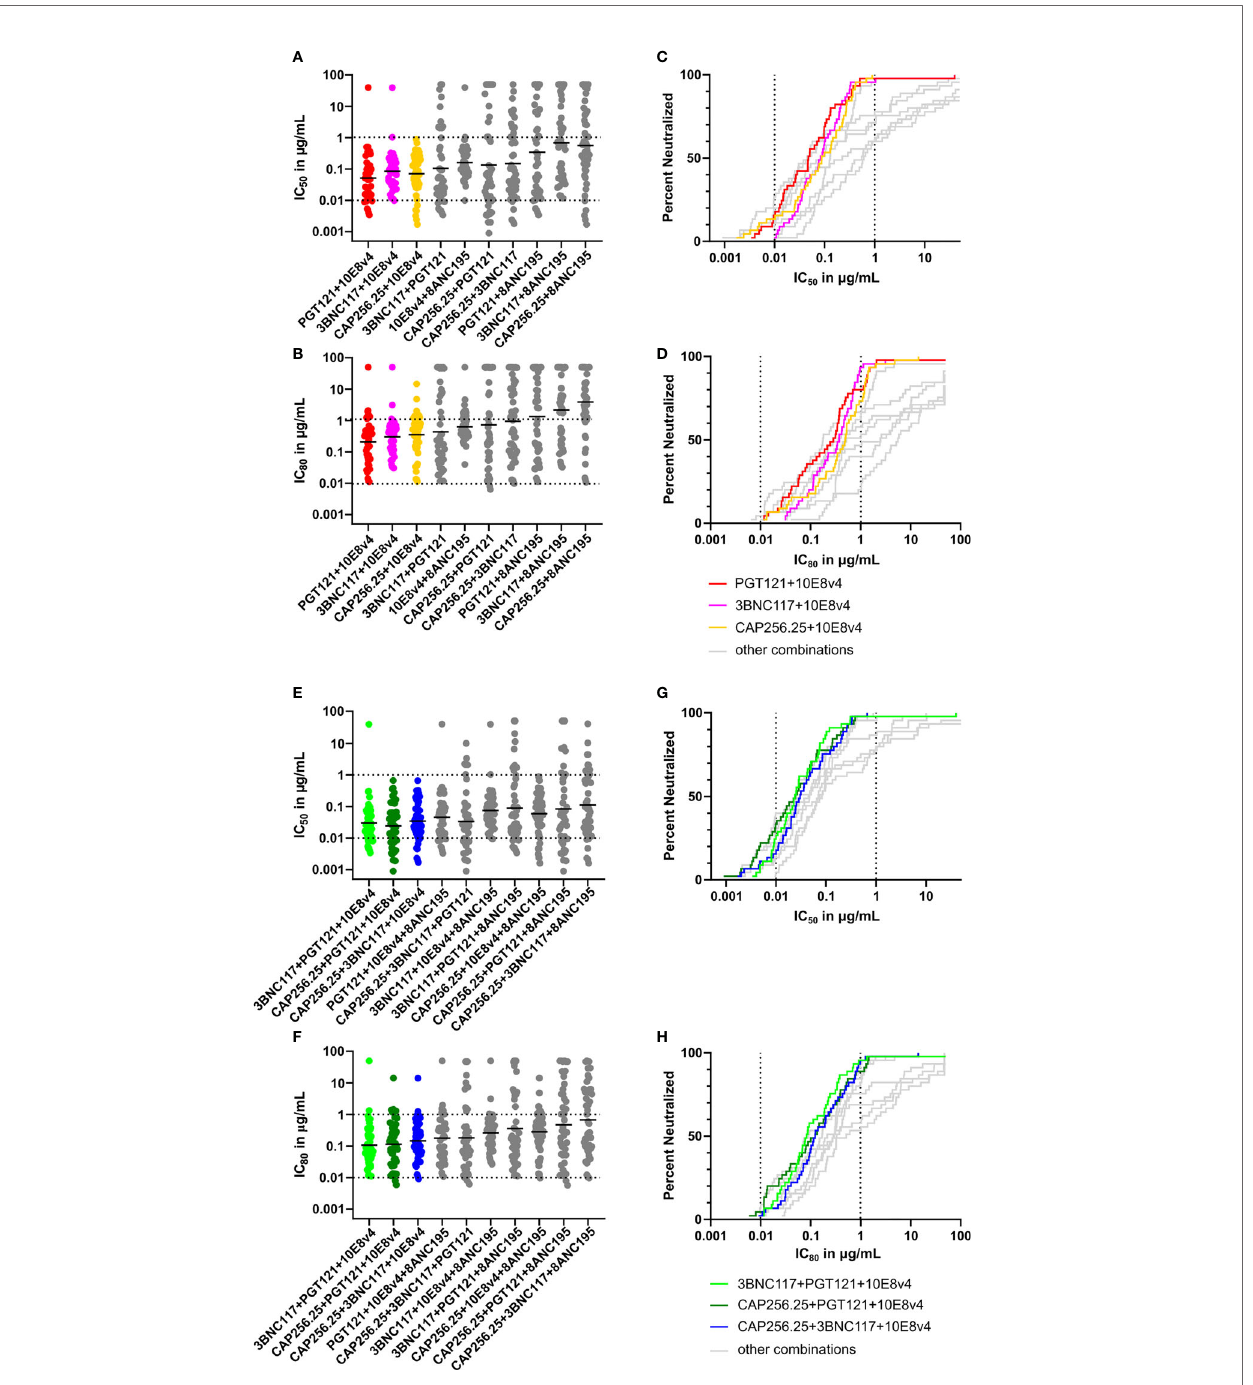
FIGURE 5 | Predicted breadth and potency of scFv combinations against large virus panel. (A) Scatter plot showing predicted IC 50 titers of dual combinations based on single scFv data for a panel of 45 viruses using the Bliss-Hill Independence model. The IC 50 data is plotted in m g/mL recalculated from nM based on the formula given in the methods section. (B) Predicted IC 80 titers of dual combinations based on the Bliss-Hill Independence model ranked by geometric mean. (C) Breadth-potency curves of IC 50 titers of most potent and broad dual combinations were plotted for the IC 50 .with the others in grey. (D) Breadth-potency curves from IC 80 data for the most potent and broad dual combinations. (E) IC 50 titers for triple combinations based on the Bliss-Hill Independence model. (F) Predicted IC 80 titers for the triple combinations ranked based on geometric mean. (G) Breadth potency curves for the IC 50 of the most potent and broad triple combinations are plotted. (H) The breadth-potency curves are based on IC 80 titers of the most potent and broad combinations. The maximum neutralization for the IC 50 and IC 80 data is set at 50 m g/mL for all plots. Geometric mean is indicated by a black line in A, C, E , and G Dotted lines are shown at 0.01 m g/mL and 1 m g/mL for breadth- potency plots IC 50 and the IC 80 (B, D, F, H) . Each scFv is present in the combination at the titer